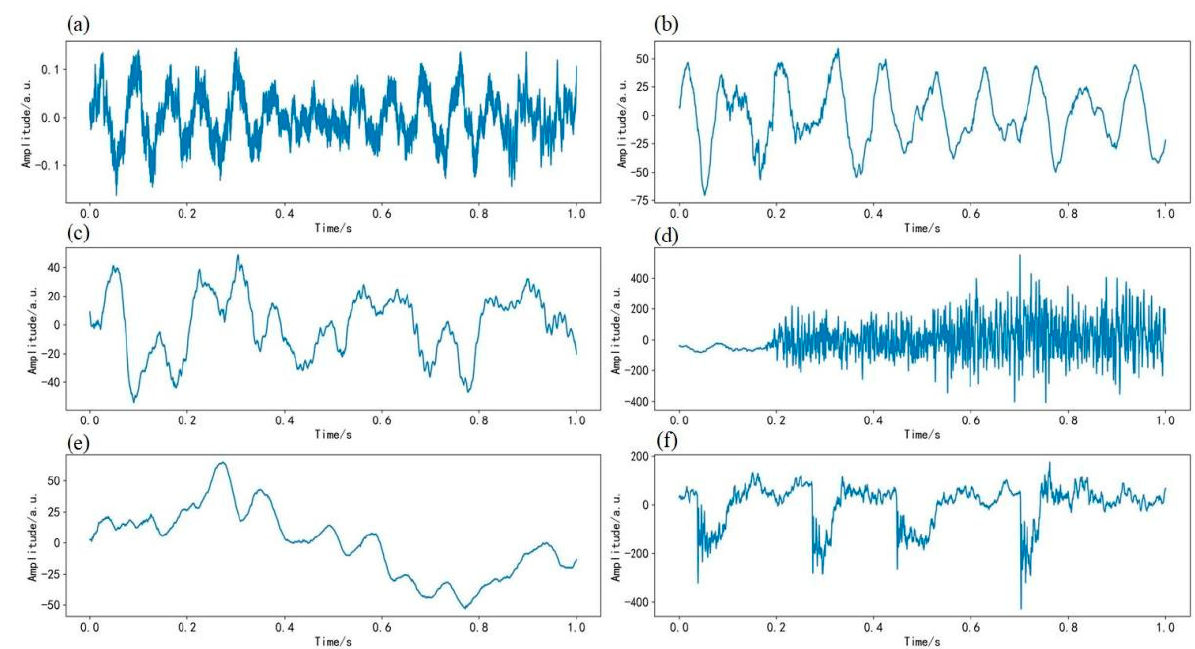
Figure 4. Amplitude diagram of six signals: ( a ) climbing, ( b ) shearing, ( c ) wind blowing, ( d ) sawing, ( e ) pushing and pulling, and ( f ) walking.